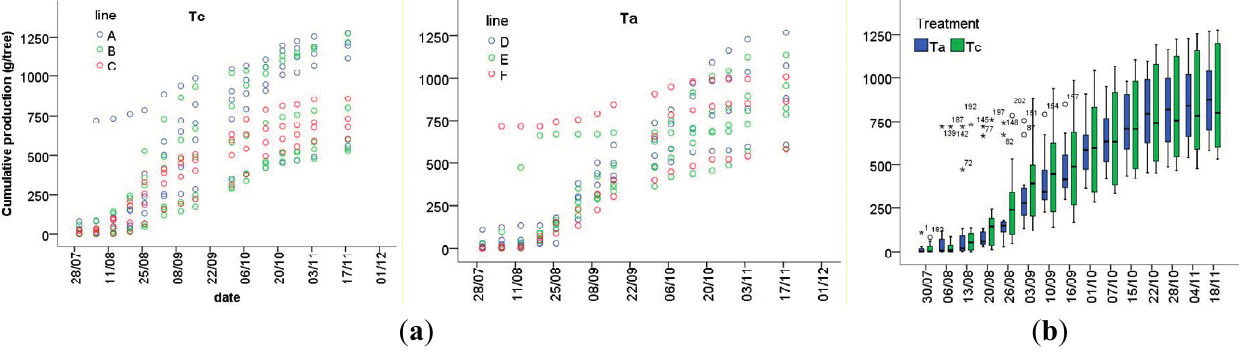
Figure 3. ( a ) cumulative production of seeds throughout the collection period (g/tree) for the three lines of each treatment (15 trees per treatment); ( b ) box-plot diagram of the cumulative production of seeds for both